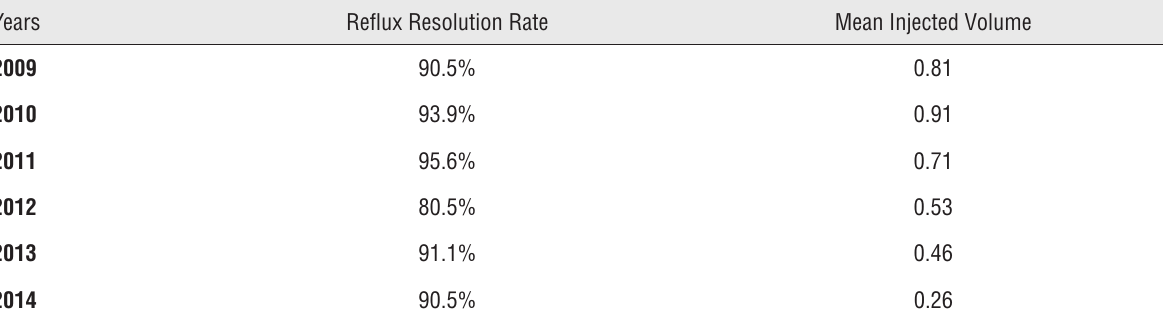
Table 3 - Reflux resolution rate and mean injected volumes through the years in PPC group.